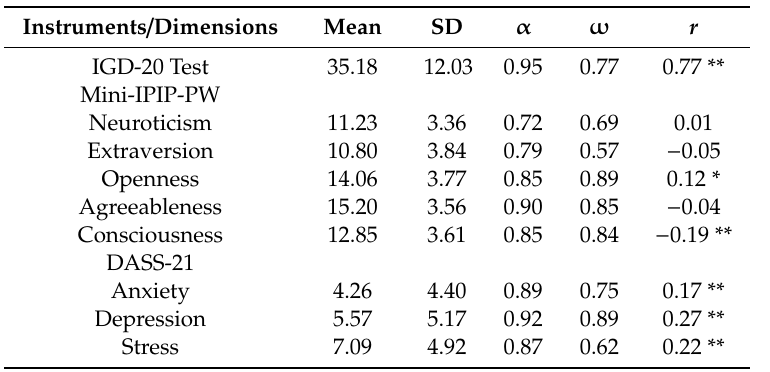
Table 1. Descriptive statistics of the Internet Gaming Disorder Test-20 (IGD-20 Test); the Mini International Personality Item Pool-Five-Factor Model-Positively Worded (Mini-IPIP-PW); and the Depression, Anxiety, and Stress Scales (DASS-21), as well as their correlations with the Internet Gaming Disorder Scale-Short Form